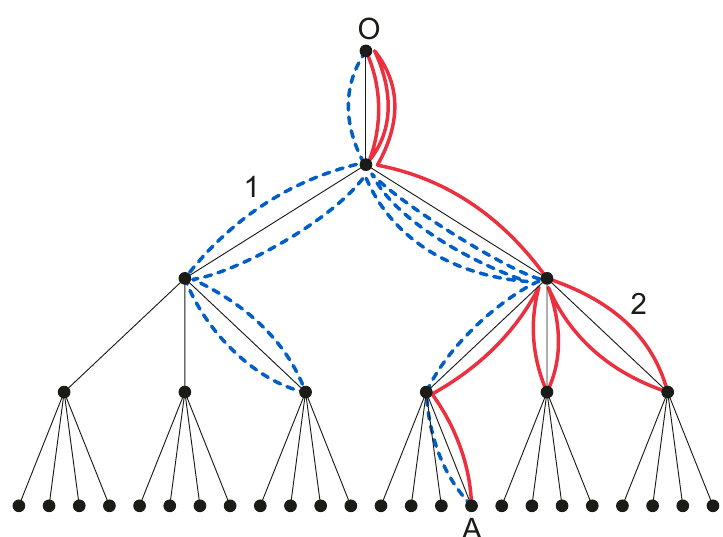
Figure 3 . Watermelon con(cid:12)guration formed by two independent trajectories of N = 10 steps each (solid and dashed). Both trajectories start from the root 0 and join at the point A on the level K of a growing